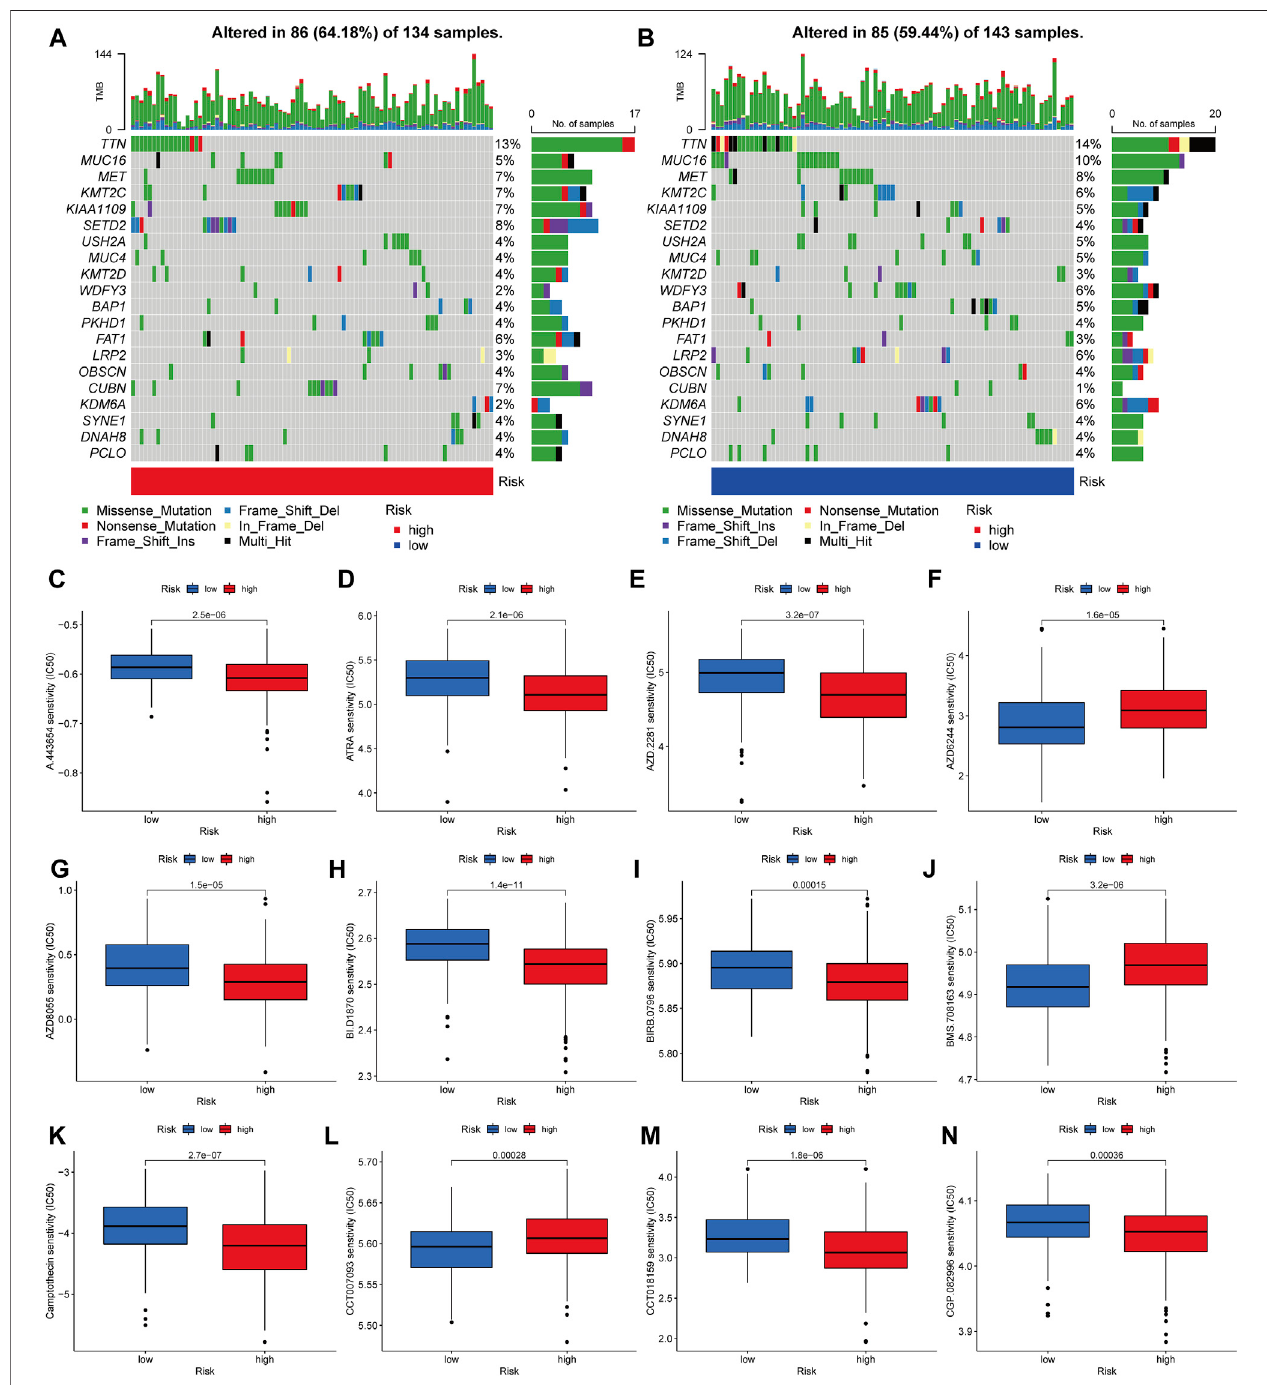
FIGURE 9 | Analyses of gene mutation and drug sensitivity. (A – B) The waterfall plot of gene mutation characteristics generated with different scores. (C – N) Correlations between PRG score and drug sensitivity.